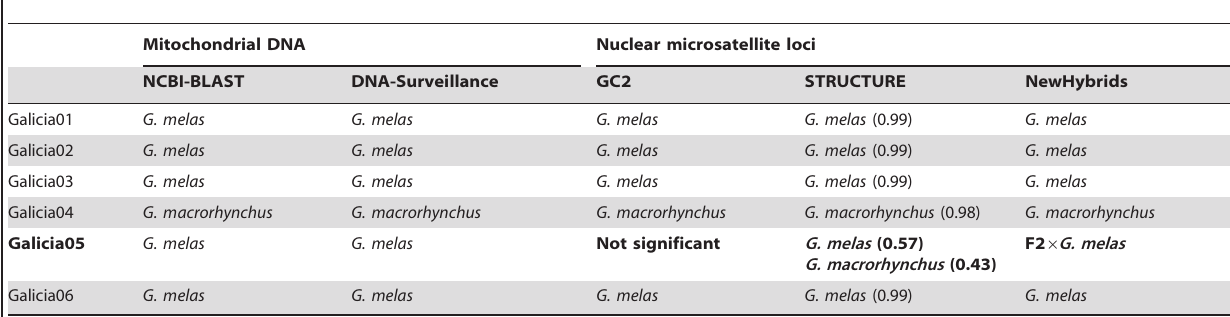
Table 4. Species assignment of stranded pilot whales based on genetic